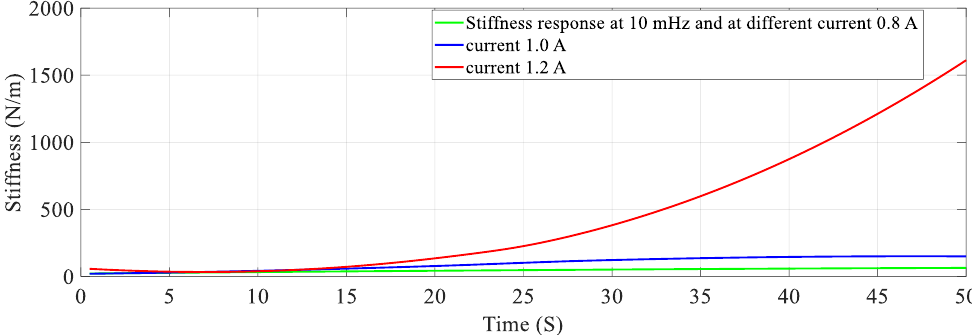
Figure 8. Stiffness of the SMA spring actuator at different currents.